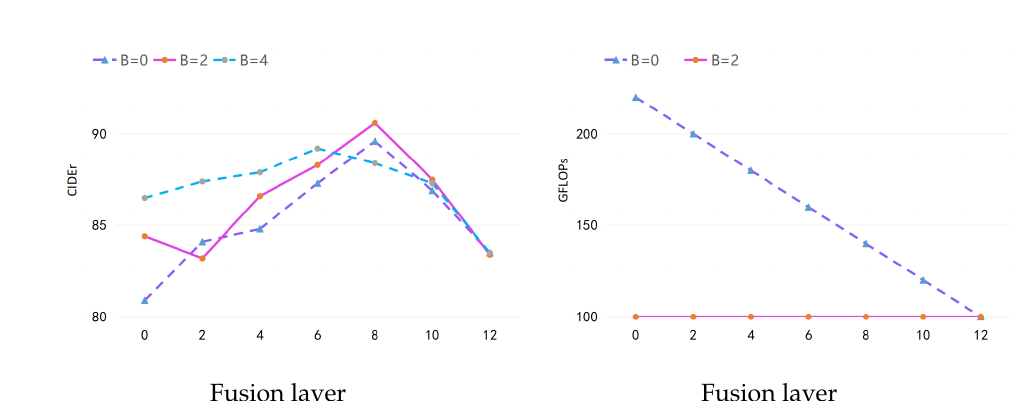
Figure 5. The impact of using the different numbers of AB modules (B is the number of AB modules) for fusion on performance ( left ) and compute ( right ) at different fusion layers on the